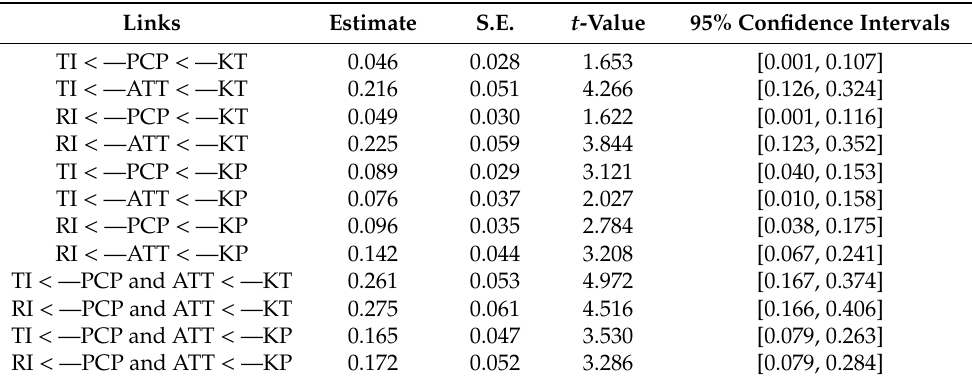
Table 7. Results of mediation e ff ect